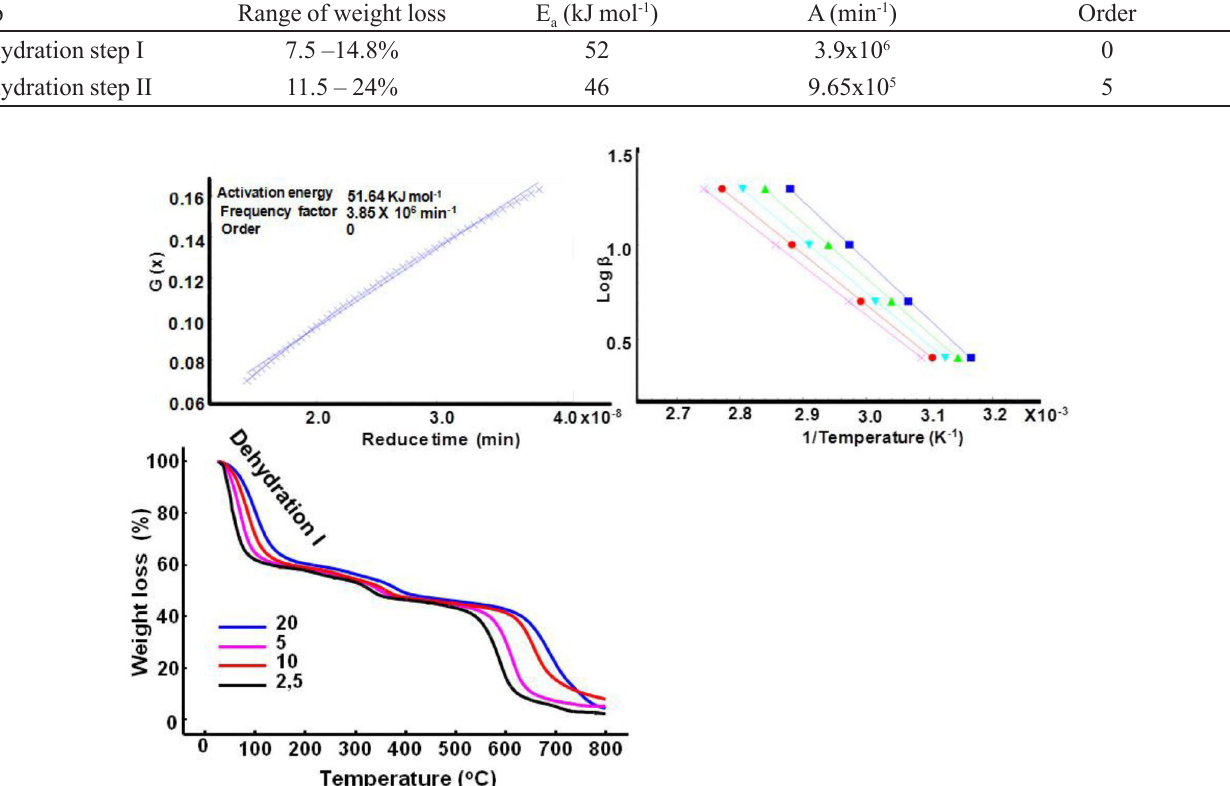
FIGURE 6 - TG curves obtained in a dynamic air atmosphere (50 mL min –1 ) with β = 2.5, 5, 10 and 20 °C min –1 , and corresponding curves of log heating rate (log β) as a function of inverse temperature (K –1 ) and the plot of G(X) against inverse temperature for dehydration step I of phytic acid